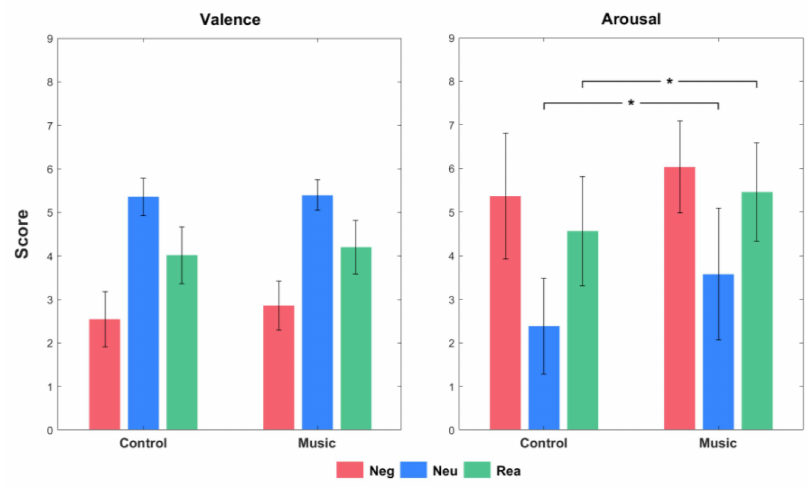
Figure 2. Behavioural results of the different conditions in the control and music group (annotations * denotes the significant interaction effect, p < 0.05).